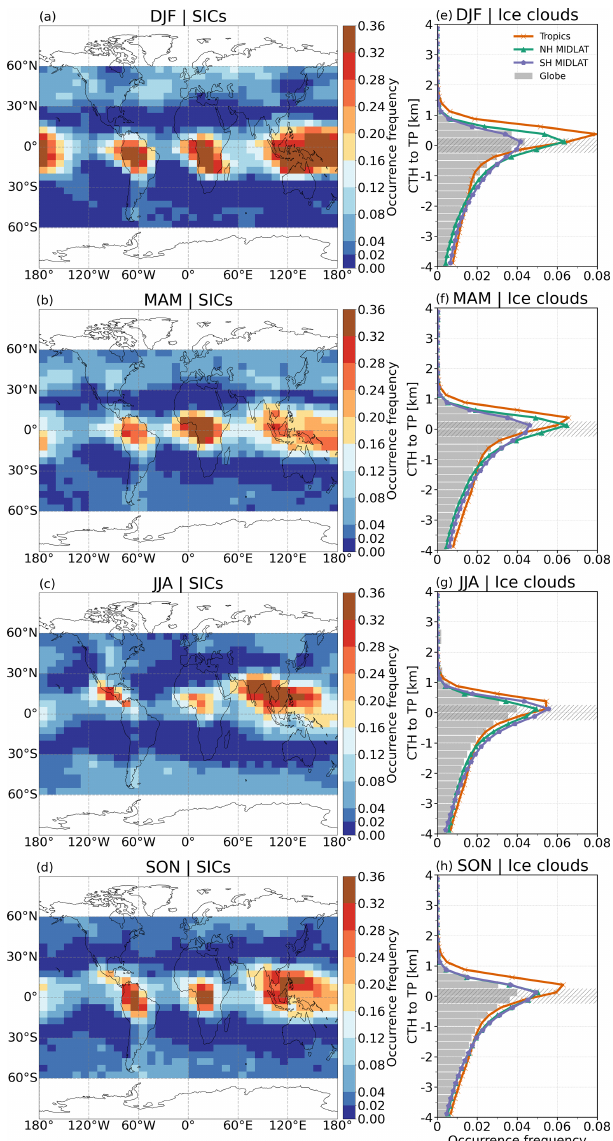
Figure 1. Occurrence frequencies of SICs on a 5 ◦ × 10 ◦ (lat- itude × longitude) grid (a–d) and occurrence frequencies of ice cloud-top heights (CTHs) in the altitude range from − 4 to 4km with respect to the first thermal tropopause (e–h) in DJF, MAM, JJA, and SON from CALIPSO measurements. In panels (e)–(h) , the data are shown as zonal averages, globally (gray bars), for the tropics (20 ◦ S–20 ◦ N; orange lines) and midlatitudes (40–60 ◦ ; green lines for NH and purple lines for SH). The hatched areas are tropopause uncertainties of ±